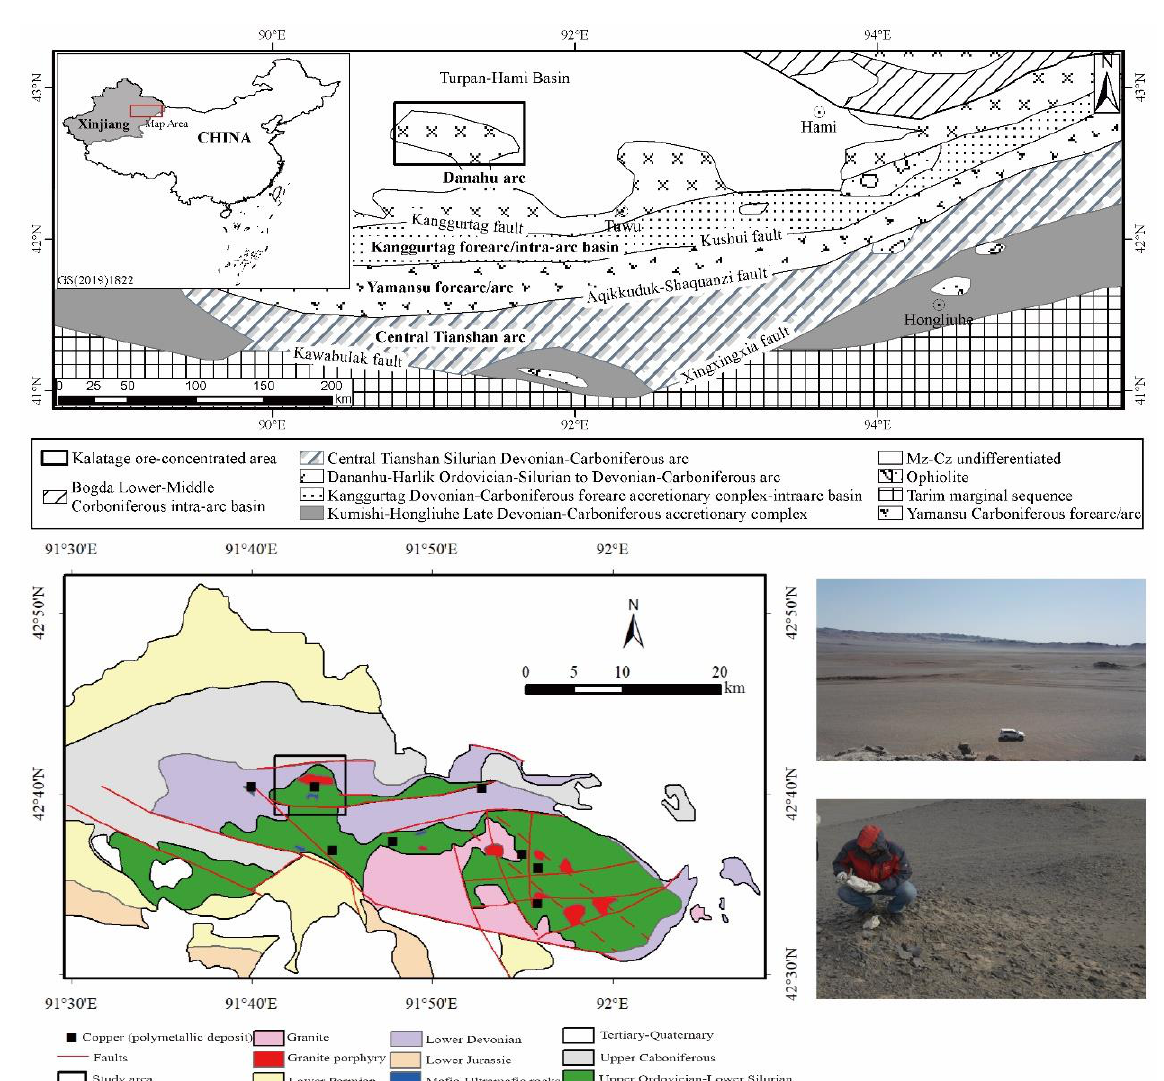
Figure 1. Geological map of the study area and the typical landscape (modified from Xiao et al., 2004 [33]; Mao et al., 2018 [31]).